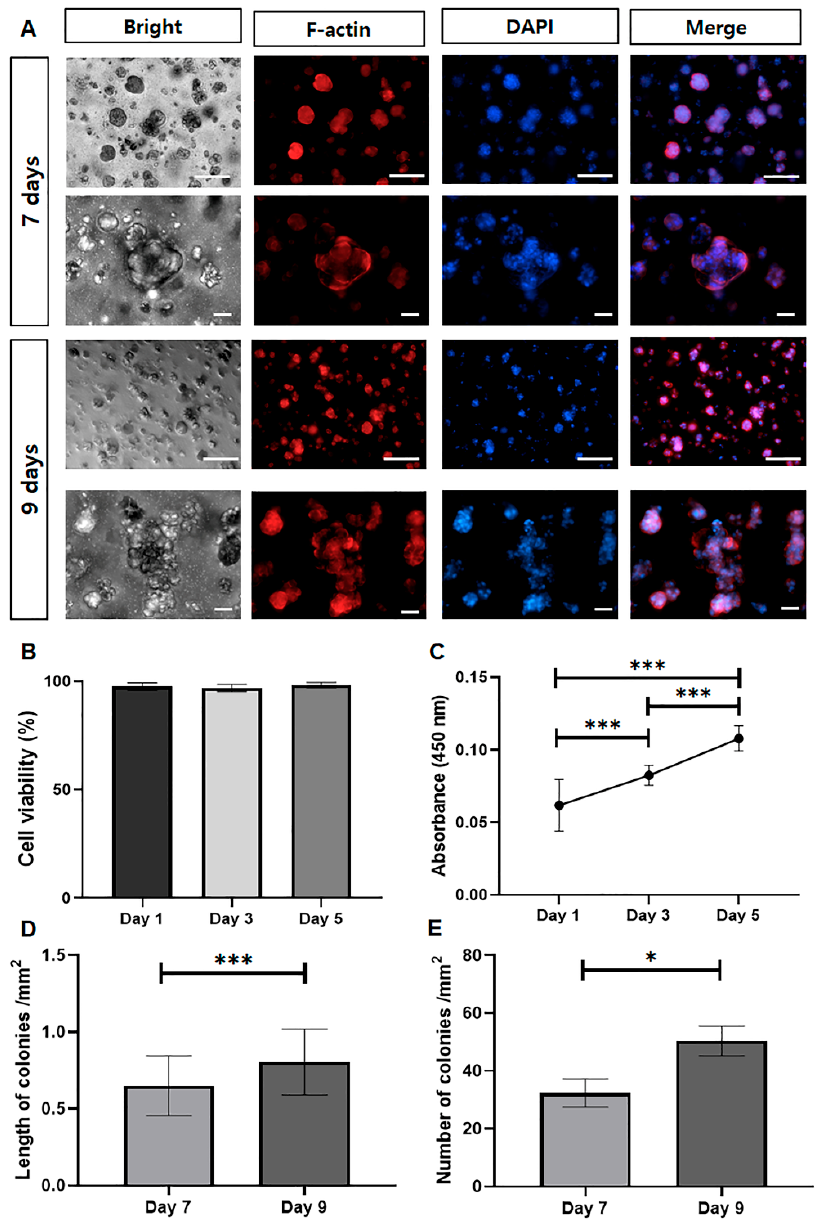
Figure 6. 3D encapsulation in MA- κ -CA hydrogel assay. ( A ) DAPI / F-actin staining image at day 7 and 9. (Scale bar = x100; 200 µ m, x200; 100 µ m). ( B ) Cell viability assay and ( C ) CCK8 assay at day 1, 3 and 5. ( D ) Length of colonies and ( E ) Number of colonies at day 7 and 9 (* p < 0.05, *** p < 0.001).